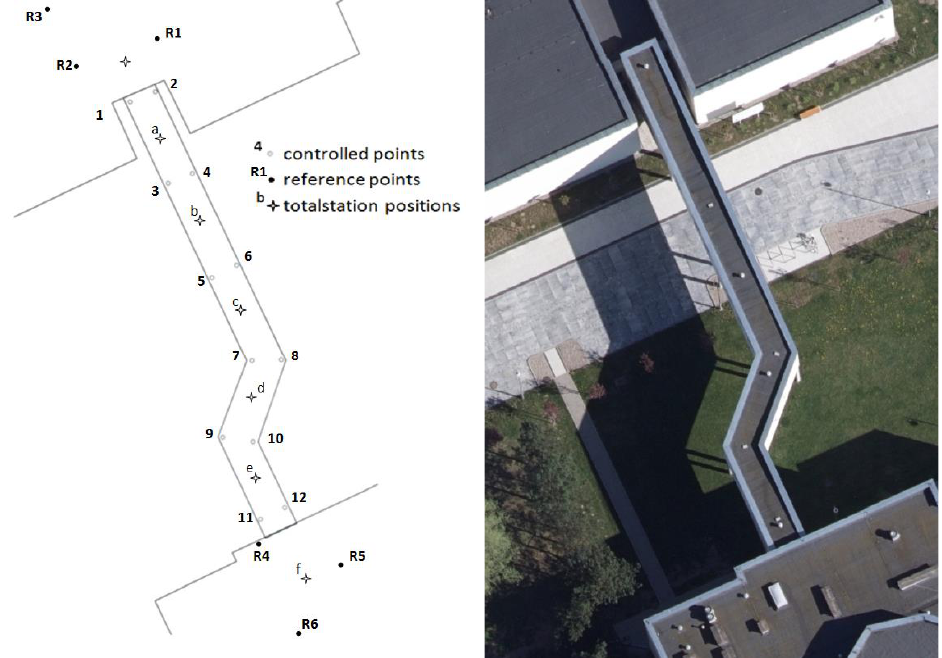
Figure 3. The scheme of the network points distribution [own analysis].